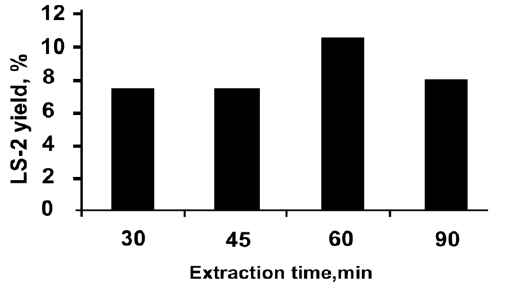
Figure 2. Elaborating optimal technology for LS-1: choosing correct concentration of extragent.